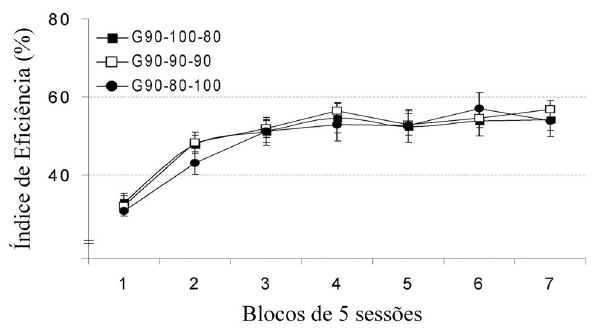
Figura 2 . Média (±EP) dos Índices de Eficiência (%) dos ani- mais em blocos de 5 sessões de treino em DRL-20 s. Nesta fase todos animais estavam a 90% do peso ad